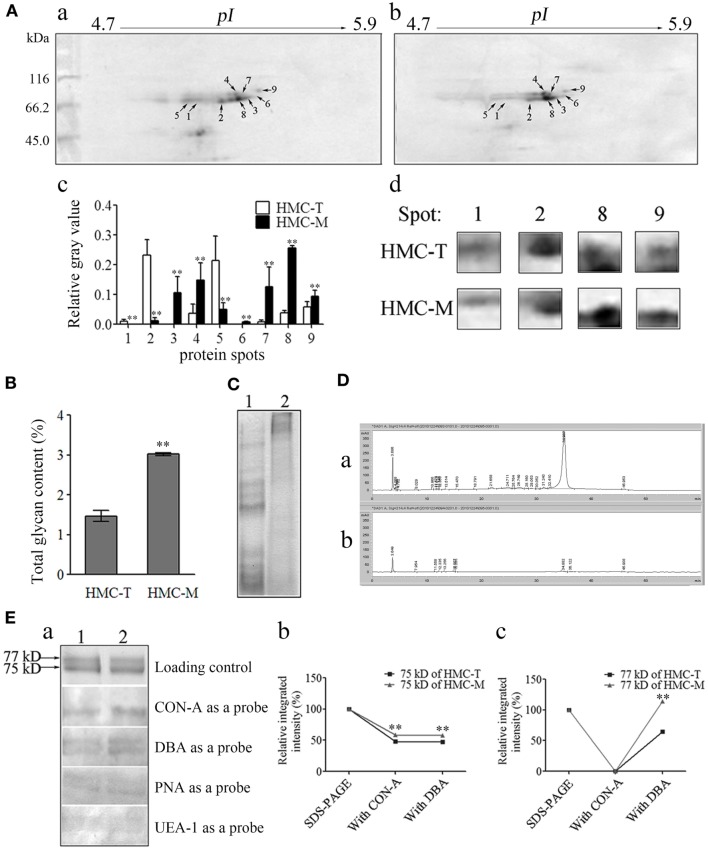
Diversity of protein and glycan modification of hemocyanin (HMC). (A) Two-dimensional polyacrylamide gel electrophoresis (2-DE) map for shrimp HMC identified by MALDI-TOF-TOF mass spectrometer and recognized by anti-shrimp HMC-T (a) and HMC-M (b). (c) Bar graph showing the gray value of differentially expressed proteins. Bars represent mean ± SD. of normalized spot intensity determined using the PDQuest software version 8.0 (Bio-Rad, CA, USA, n = 3). (d) Highlight of partial differentially expressed protein spots. (B) Glycan concentration of HMC-M compared to HMC-T using the method of phenol-sulfate acid. Data represent the mean ± SE. of at least three independent experiments, **p < 0.01. 1, HMC-T; 2, HMC-M. (C–F) Glycan components between HMC-T and HMC-M. Tricine-SDS-PAGE (C) and high-performance liquid chromatography (HPLC) analysis (D). (1)/(a), HMC-T; (2)/(b), HMC-M. Lectin blot analysis using biotinylated lectin (E). (a) One-dimensional sodium sulfate-polyacrylamide gel electrophoresis (1-DE) for lectin blot analysis. Concanavalin A (CON-A), dolichos biflorus agglutinin (DBA), peanut agglutinin (PNA), or ulex europaeus agglutinin 1 (UEA-1) (1:5) and peroxidase-conjugated avidin (1:1,000). (b and c) Relative integrated intensity of HMC-T and HMC-M. (F) Far-Dot-ELISA analysis. (a) Far-Dot-ELISA using HMC-T (1) or HMC-M (2) as a bridge, and rabbit anti-shrimp HMC-T antisera and goat anti-rabbit IgG-HRP (1:3,000) antibodies used as primary and second antibodies, respectively. (b) Relative integrated intensity of dot (1:1 of CON-A) between HMC-T and HMC-M. (G) Hemolytic activity between MHC-T and MHC-M with or without carbohydrate epitopes. These data represent the mean ± SD of at least three independent experiments, **p < 0.01.